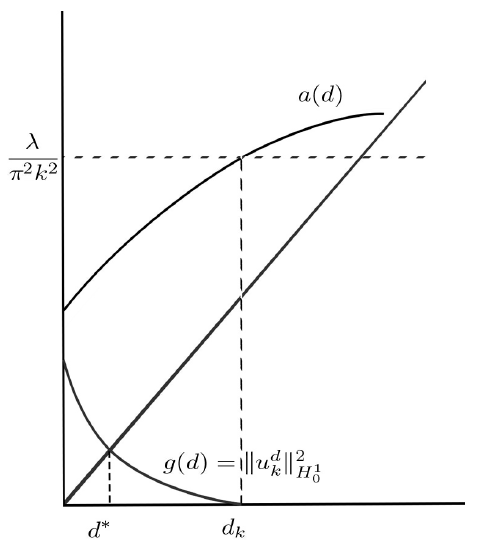
Figure 1. a ( d ) non-decreasing.